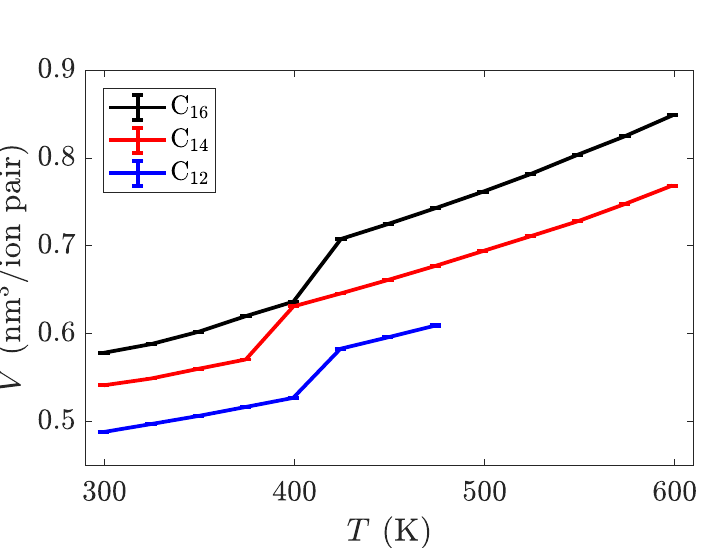
Figure 4. Intrinsic volume per ion pair as a function of temperature for three different alkyl chain lengths. The most dramatic jump in volume is between the crystalline and smectic phases. The right- most point on each line is where the material melted into an isotropic liquid. Transition temperatures are summarized in Table 1.